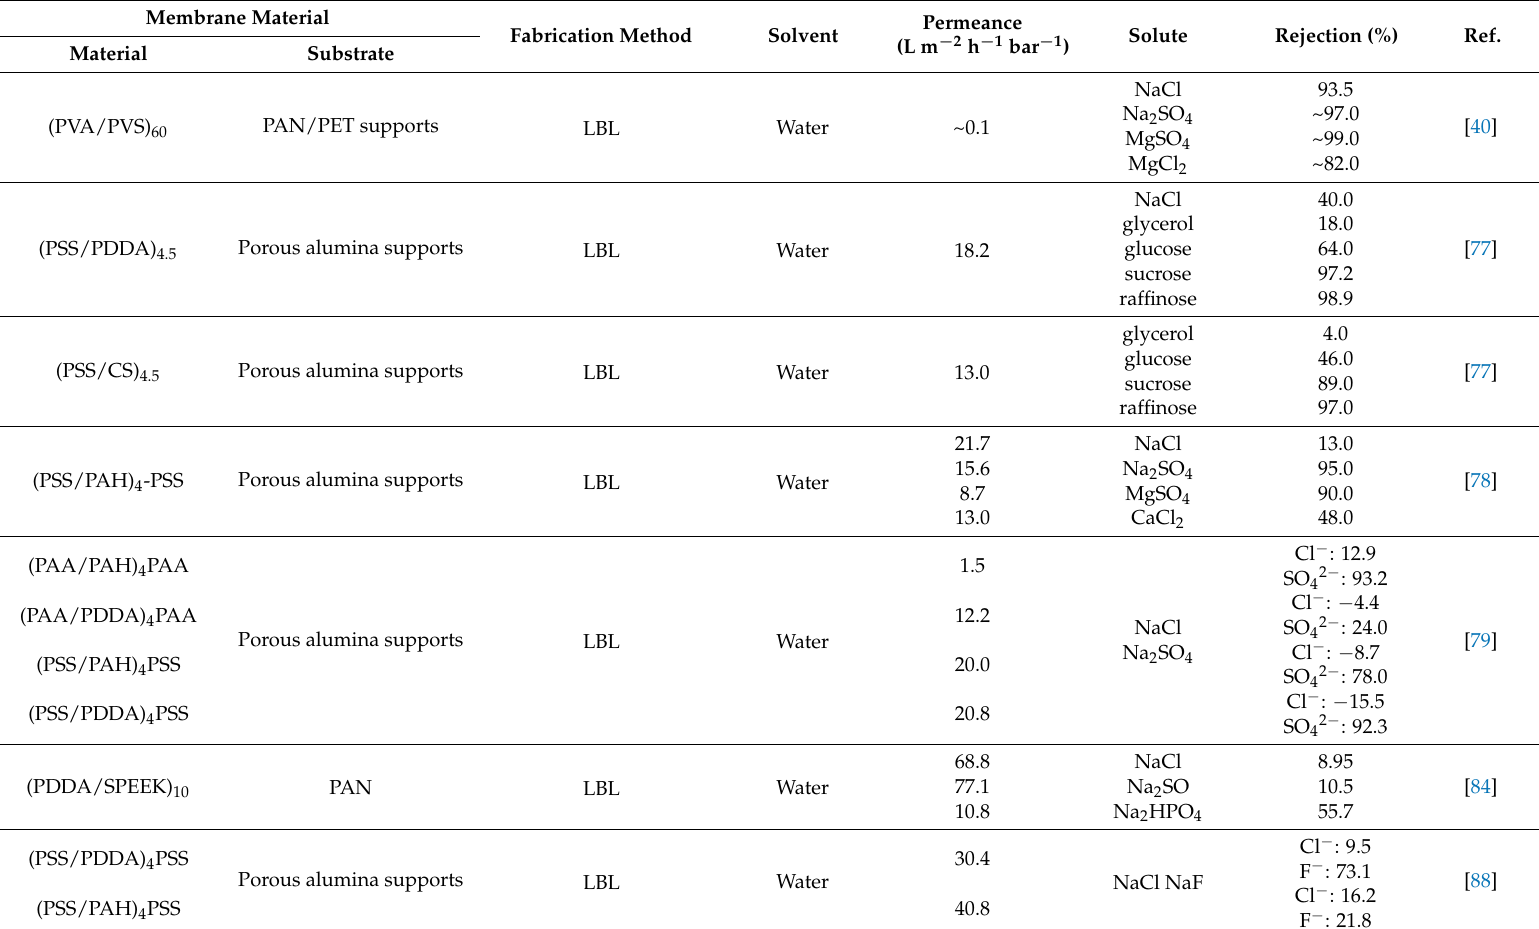
Table 1. Summary of materials, method, and performance of polyelectrolyte membranes containing ion